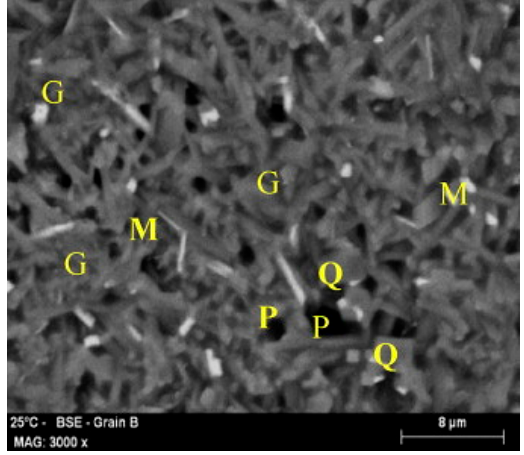
Figure 4. SEM micrograph of a BSAA refractory brick (halloysite and KT kaolin brick) fired at 1350 °C. M: mullite needles; Q: quartz; G: amorphous phase; P: pores [41].